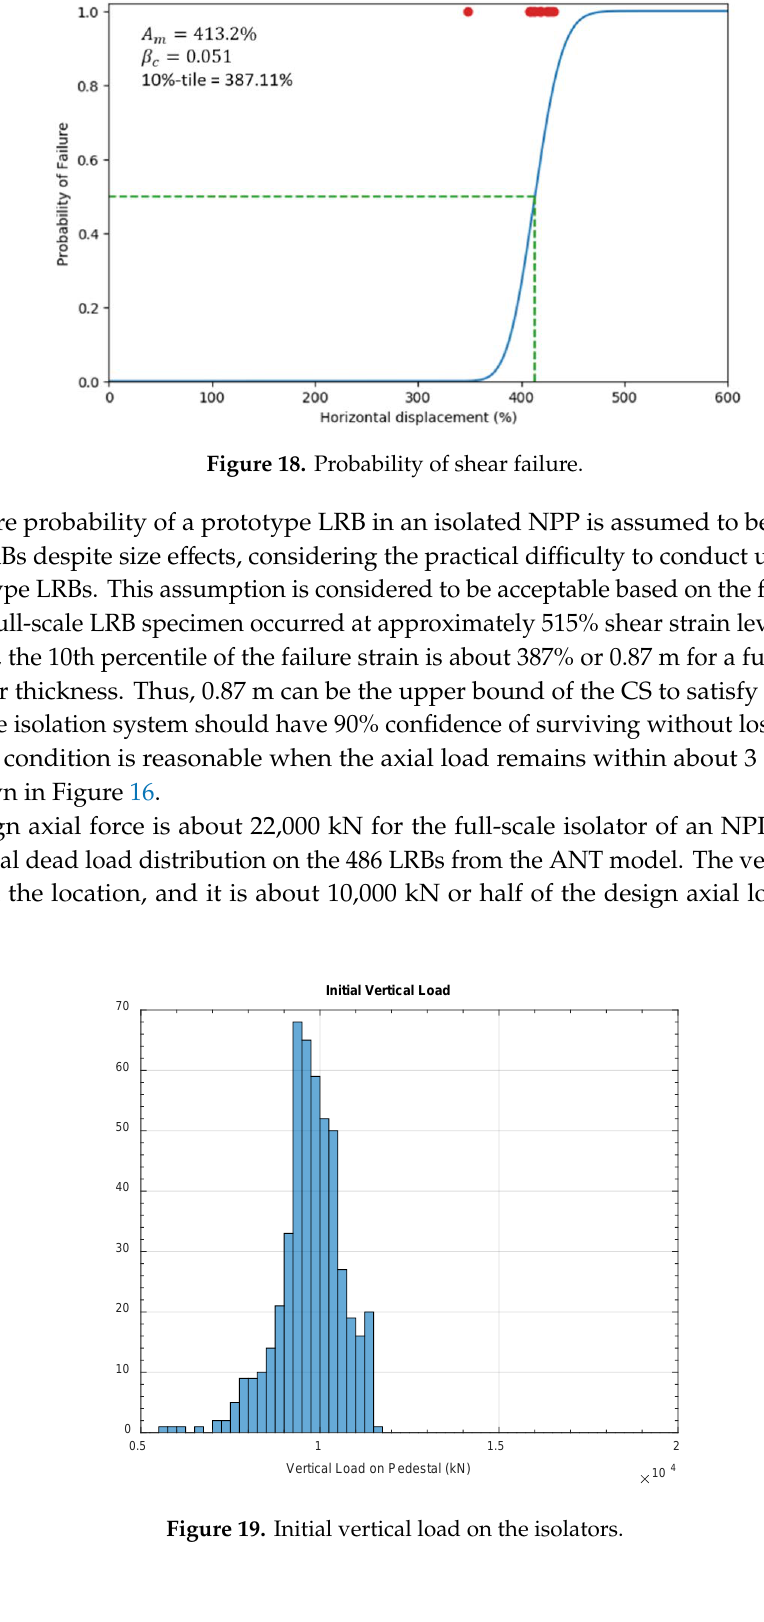
Figure 19. Initial vertical load on the isolators.